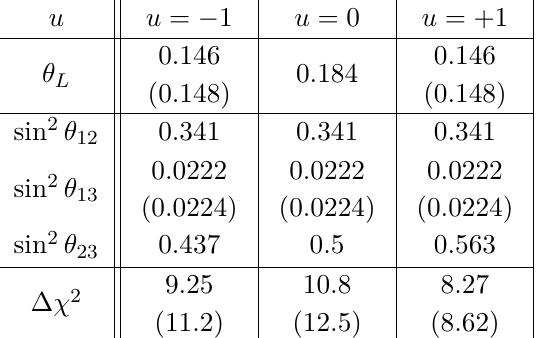
Table 1 . Case 2) Results of θ L and lepton mixing angles for n = 14 and the admitted values of the parameter u . Note that other combinations of u and θ generated with symmetry transformations, L discussed in [22], as well as considering π − θ also lead to a viable description of the experimental L data on lepton mixing angles. We additionally show the value of ∆ χ 2 , arising from a fit to the global fit data, provided by the NuFIT collaboration [41]. Results in brackets refer to light neutrino masses with